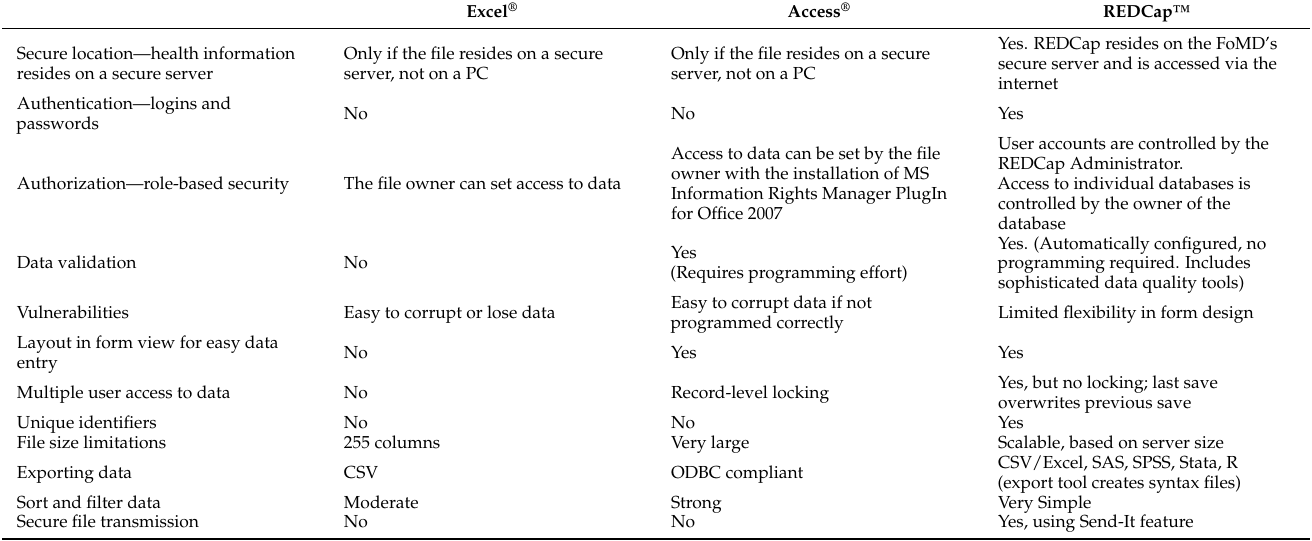
Table 1. Summary of the potential advantages of a web-based computerized data collection and management system. Adapted from https://www.ualberta.ca/medicine/media-librSary/resources/medit/comparison---excel-access-redcap- -2015-09-03.pdf (accessed on 1 March